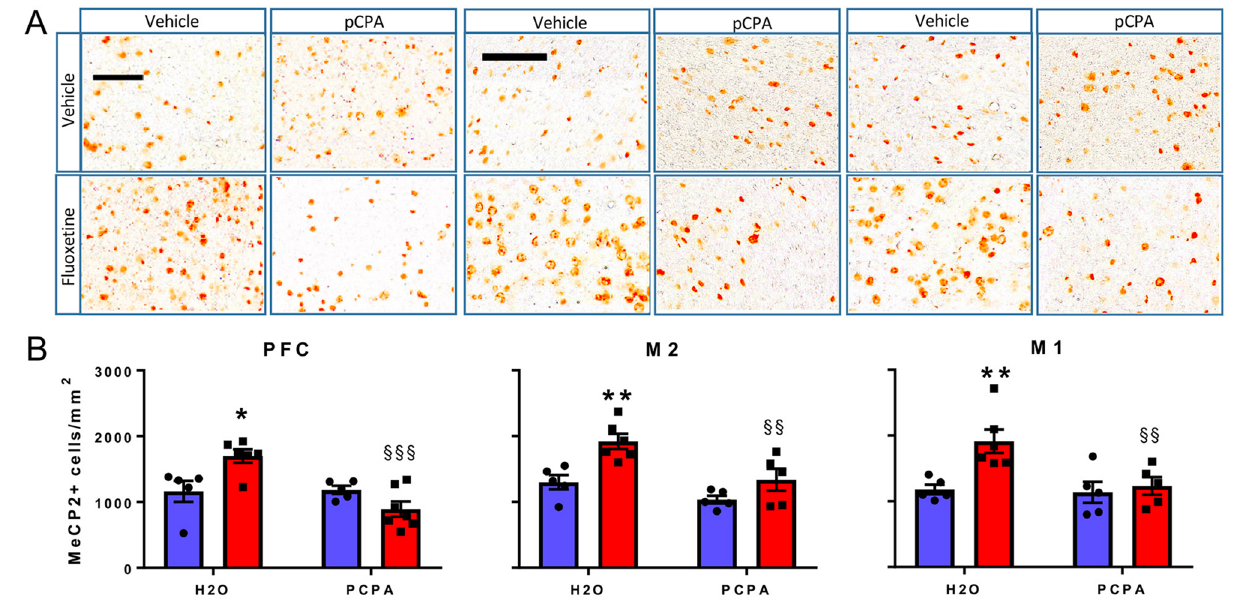
Figure 4. Reversal of FLX-induced rise of MeCP2 + cells by the 5-HT synthesis inhibitor pCPA in the PFC, M2 and M1. ( A ) Enlargements of the original pictures obtained by the VS120 microscope showing MeCP2 + cells (brown dots) in representative sections of the PFC, and M1 and M2 motor cortices of Mecp2 HET mice treated with 10 mg/kg FLX or water (H 2 O) for 17 days plus PCPA or H 2 O from days 15 to 17. On day 18, mice were euthanised and their brains processed for MeCP2 immunohistochemistry. Scale bars, 100 µm. ( B ) Histograms, generated with the Prism software (version 7.02; https:// www. graph pad. com/ scien tific- softw are/ prism/), show the mean number (± SEM) of MeCP2 + cells (5–7 mice/group) . Blue and red columns indicate treatment with vehicle and FLX, respectively. Black dots and squares indicate individual data points. * P < 0.05 and ** P < 0.01 versus